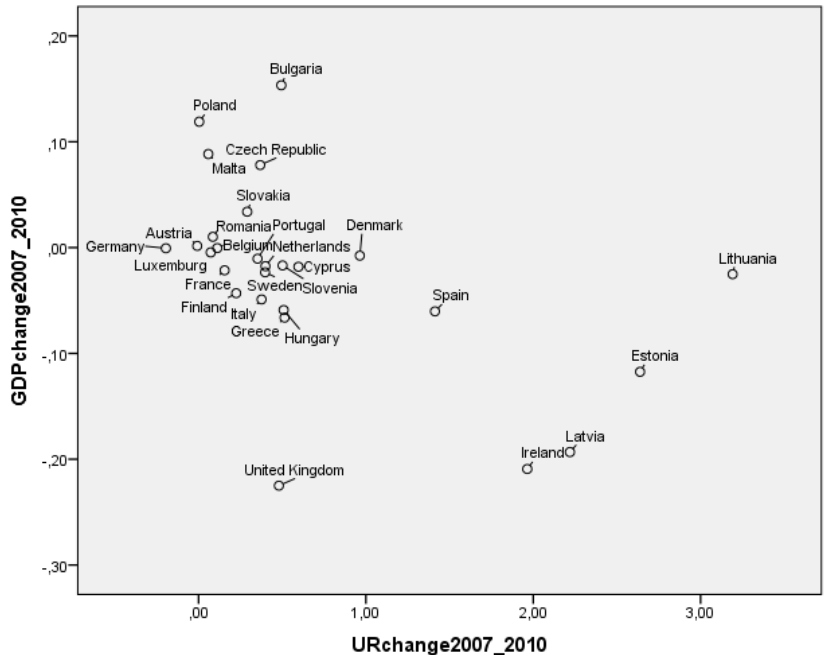
Figure 1. Change of GDP per capita and change in unemployment rate between 2007 and 2010 (in %). Source: World Bank indicators: